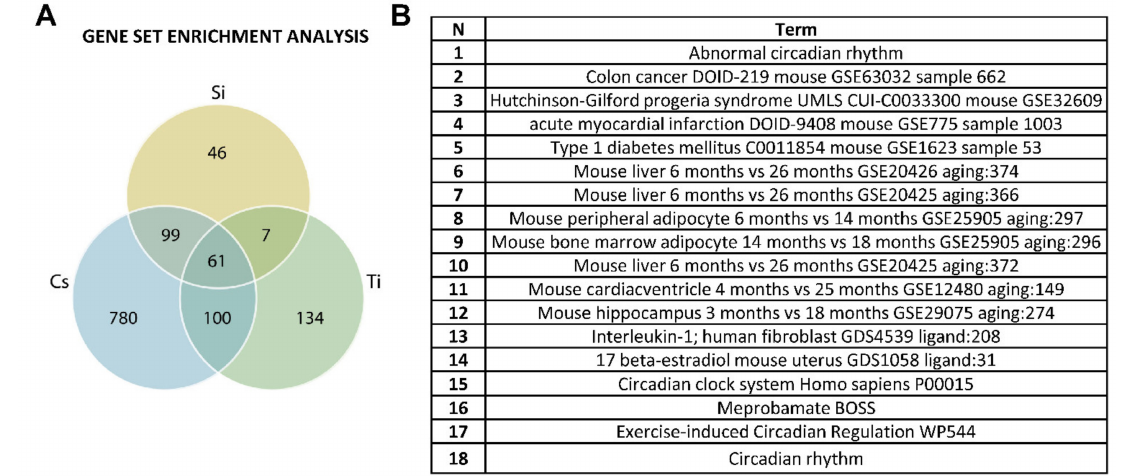
Figure 7. Overlapping biological processes: ( A ) Venn diagram analysis of differentially expressed genes across all three different radiation exposure groups/doses compared to controls. In each paired test, the differentially expressed genes were identified as a log2 fold change and p < 0.05. In the diagram, blue circles represent genes putatively affected by long-term 137 Cs exposure, green circles represent genes influenced by 14 Si exposure, and yellow circles represent genes that were putatively affected by 22 Ti exposure. ( B ) The table represents various biological processes that are common for all three radiation